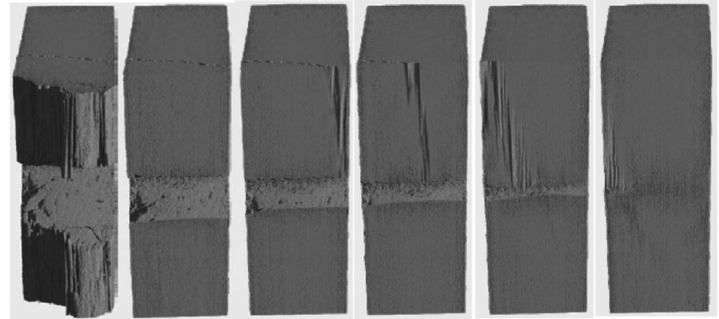
Fig. 12. Views of successive sectioning at 5 intervals of 0.2 mm along the y axis after 250 impacts (Note that the notch depth is 1 mm).